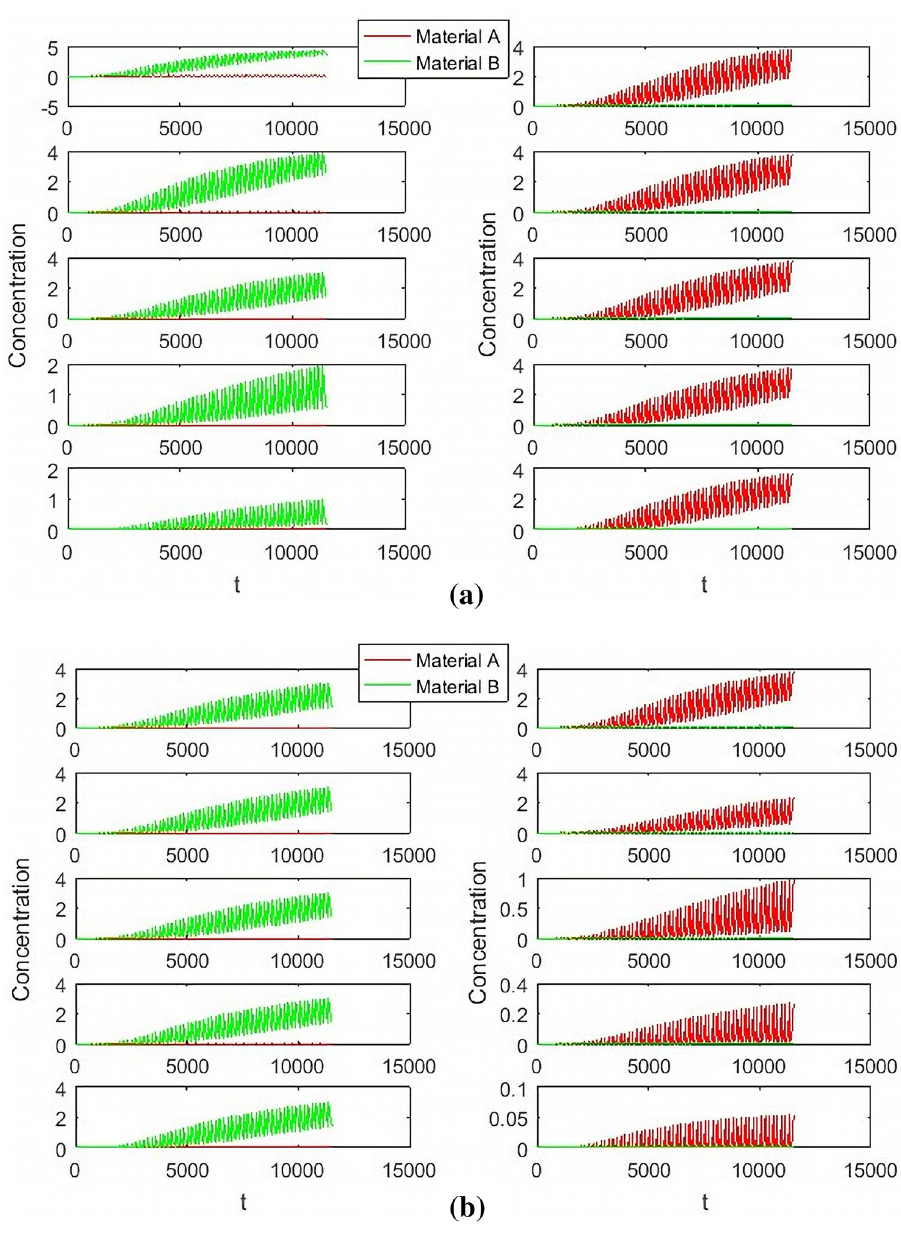
Figure 5. The influence of Zone 1,2 Flow rate for